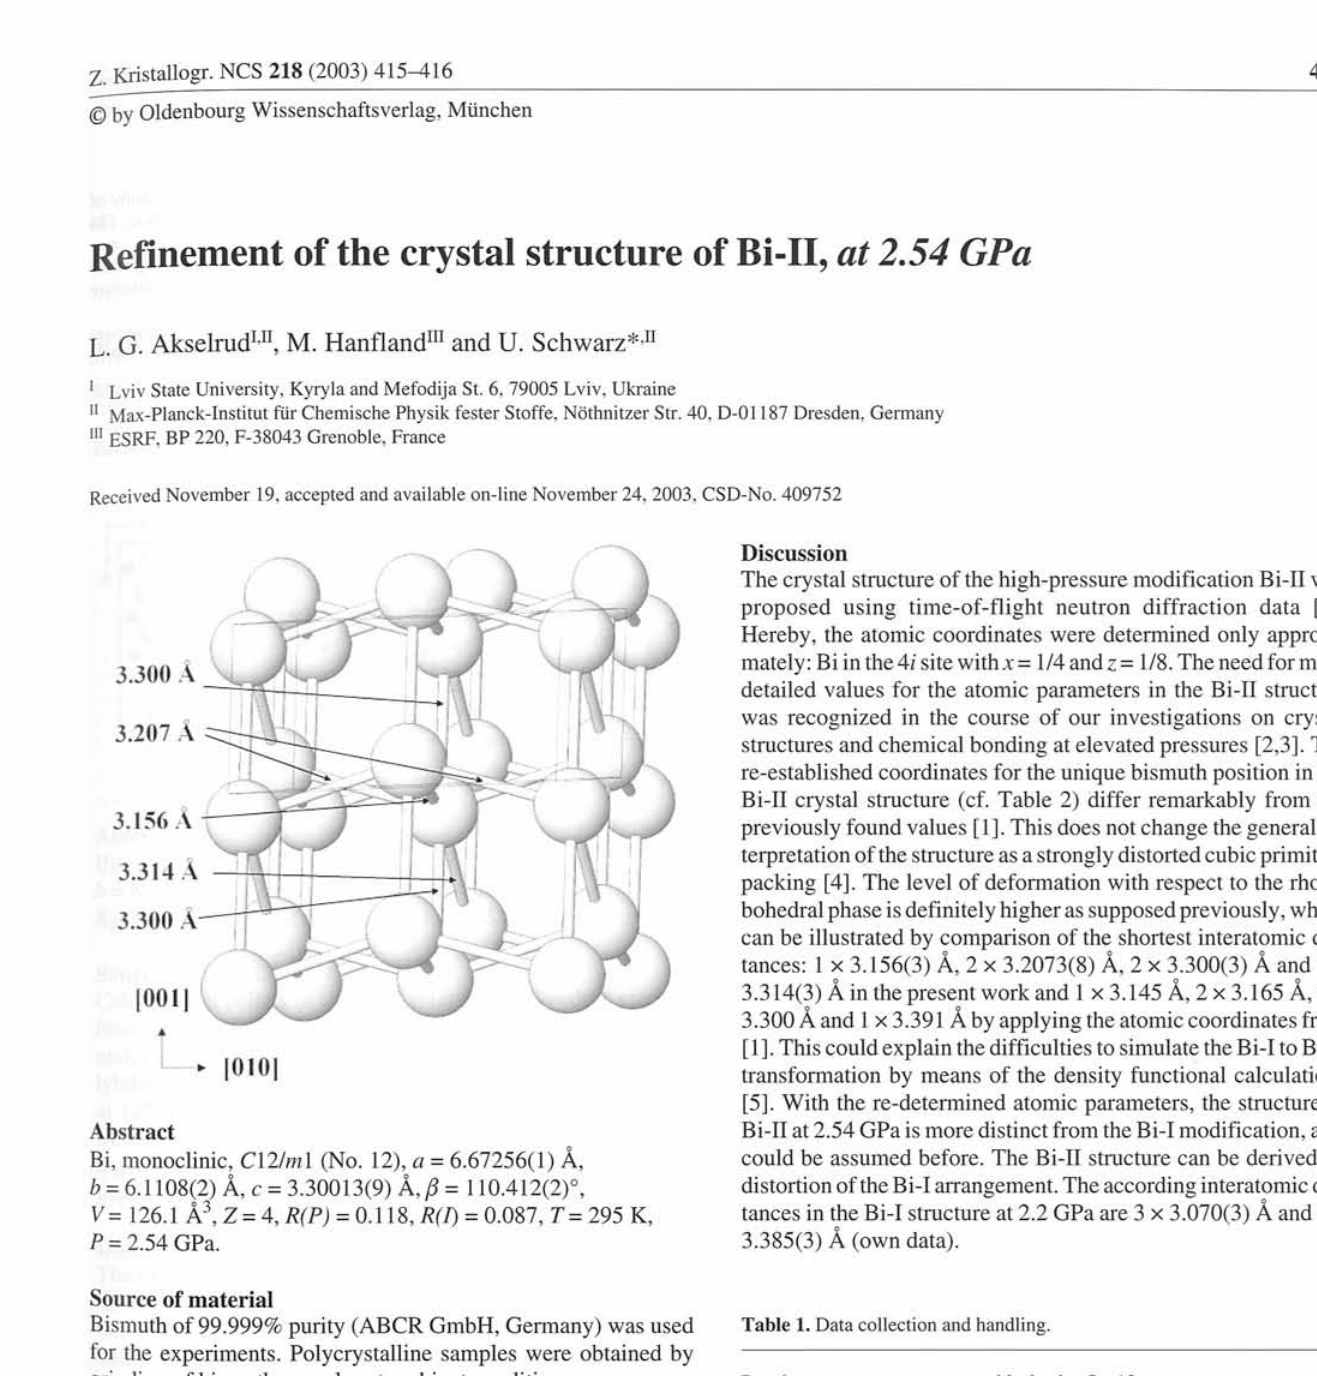
Table X. Data collection and